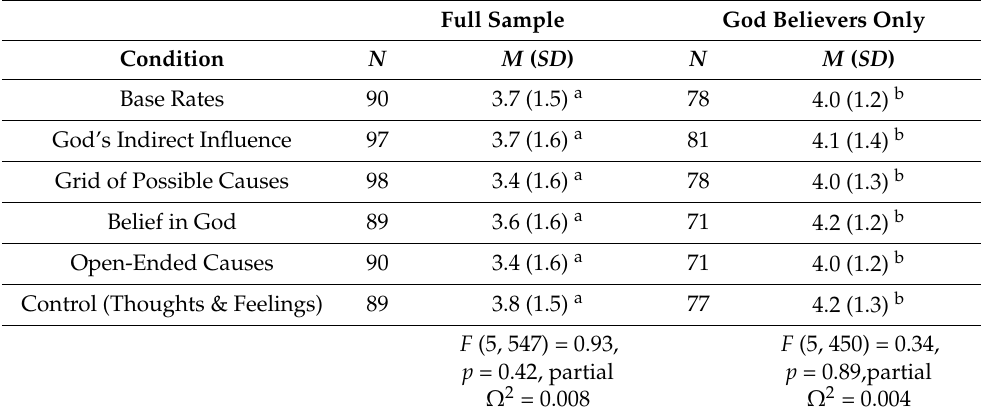
Table 3. Effects of Experimental Condition on Gratitude to God (Likert